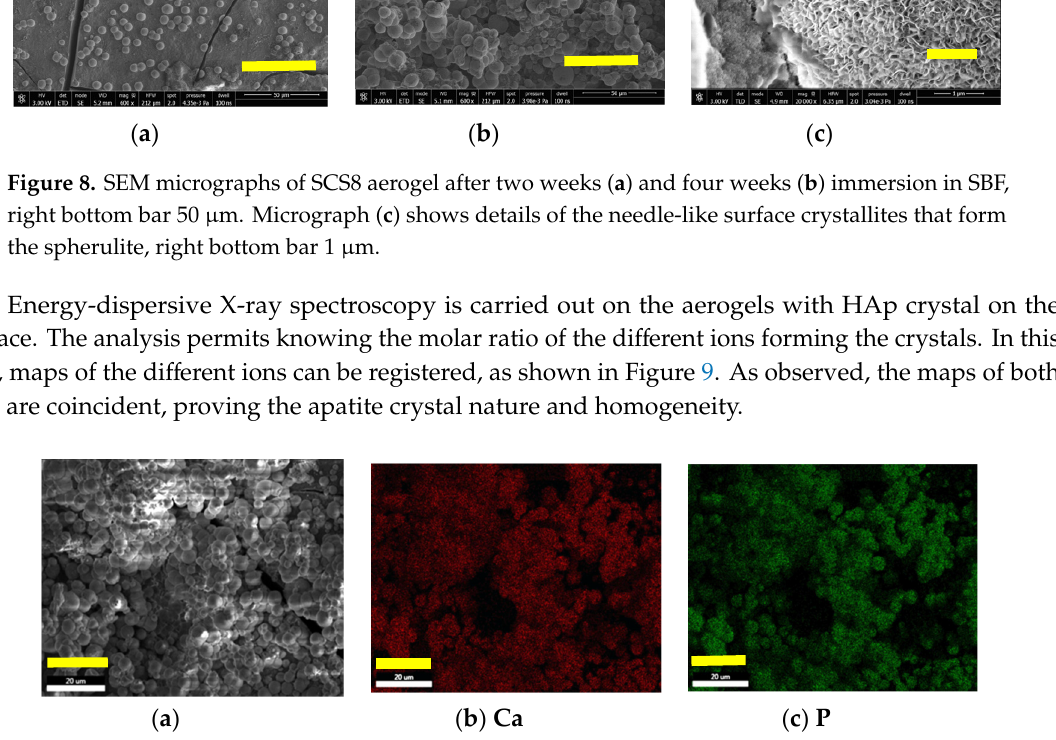
Figure 10. HOB ® osteoblasts grown on SCS8 sample after 24 h in culture ( A ) and examined with a phase-contrast microscope, showing cell elongation, organization, and polarization towards aerogel